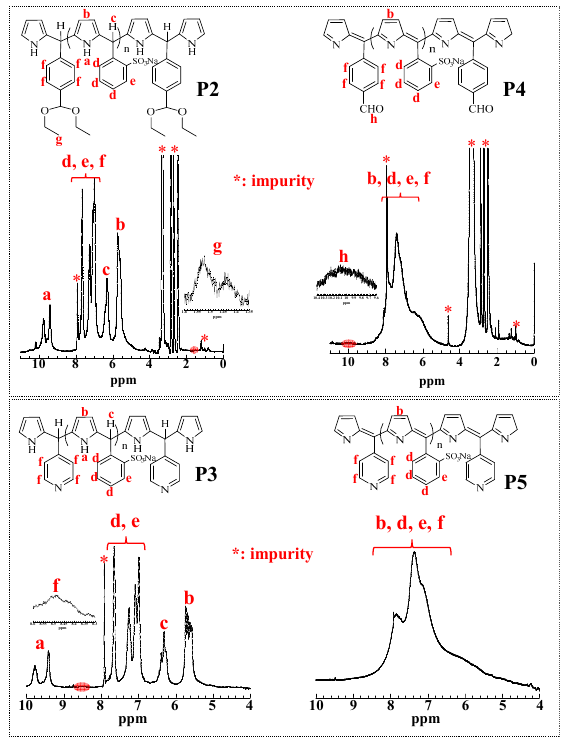
Figure 1. 1 H-NMR spectra of P2 – P5 in DMSO-d 6 .